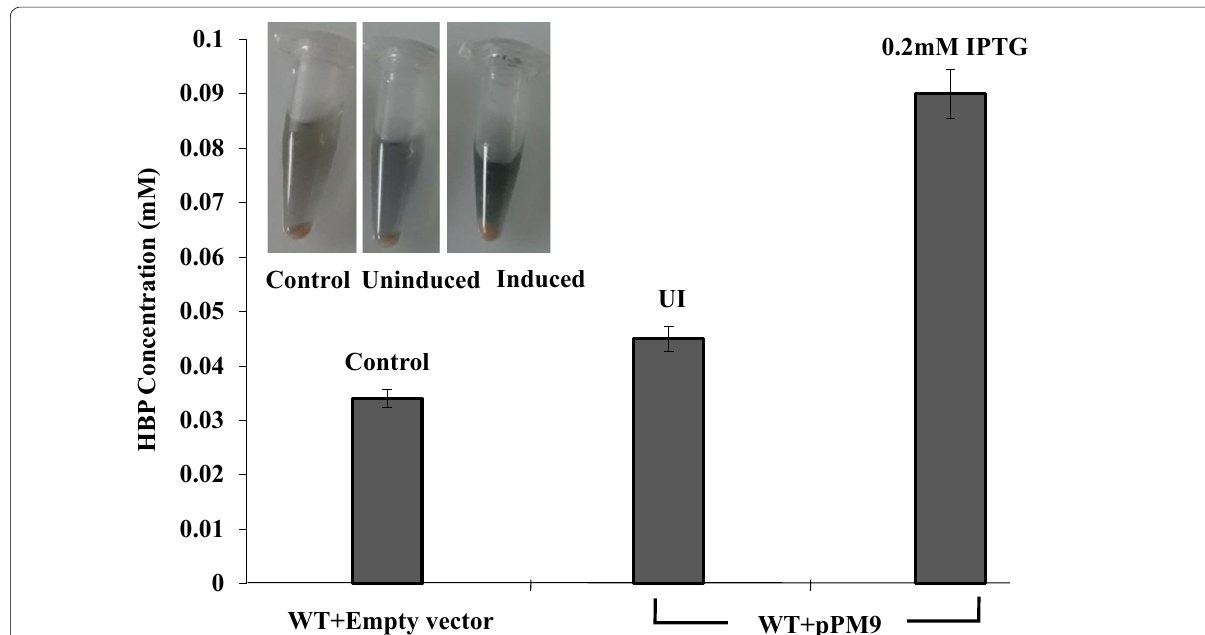
Fig. 6 Graph showing an increase in activity of the dsz operon in Rhodococcus erythropolis IGTS8 when the TetR family protein is induced with 0.2 mM